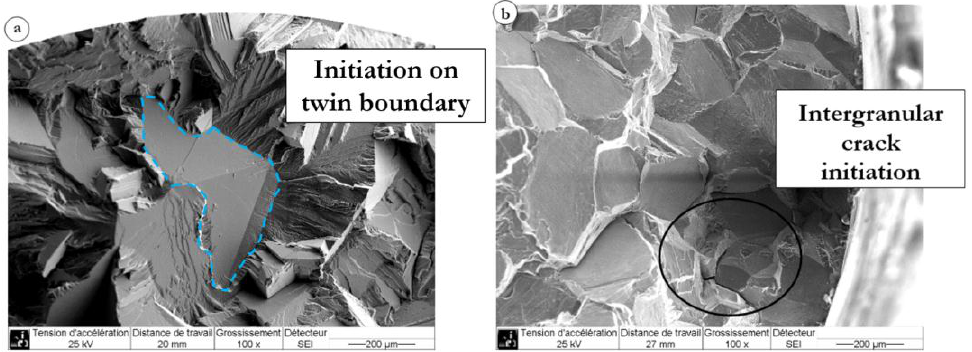
Figure 6. SEM fracture surfaces observations of specimens after creep-fatigue test at 700 °C and σ max = 850 MPa on the coarse grains microstructure: ( a ) Δ t = 3 s, ( b ) Δ t = 300